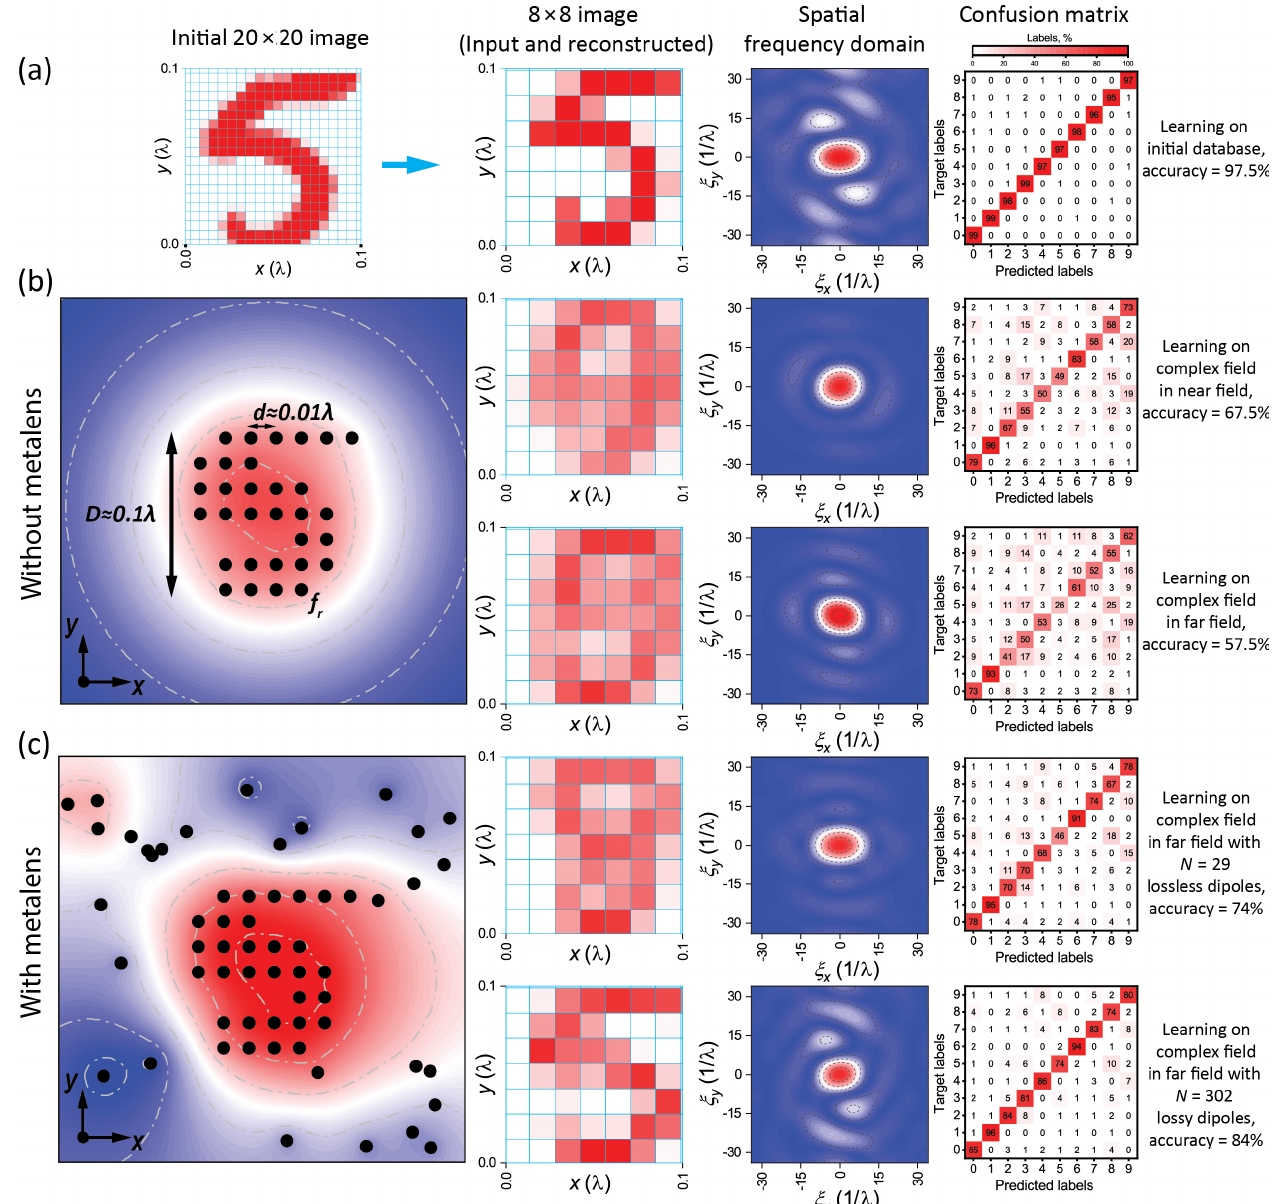
FIG. 2. Demonstration of subwavelength handwritten digits reconstruction and classification based on a semianalytical model of 2D coupled dipoles. (a) The initial ( 20 × 20 )-pixel image of a handwritten digit taken from the MNIST database (left inset) and downsampled to ( 8 × 8 )-pixel image (second column) with corresponding distribution in spatial frequency ξ space (third column). The PCNN classifier trained on the downsampled database reaches an accuracy of 97.5% (the corresponding confusion matrix shown in the right inset). (b) The subwavelength image is modeled by an array of dipoles placed at distances d ≪ λ and with resonance frequency f ≫ f r 0 to inhibit multiple scattering resonance. Reconstructed image (second column) and its corresponding reciprocal space domain (third column), which show the failure of UCNN to recover the higher spatial frequencies. Thus, the accuracy of the PCNN classifier trained on these reconstructed images reaches approximately 67.5% in the near field (top row inset) and 57.5% in the far field R ≫ λ (bottom row inset). (c) Introducing a metamaterial lens that consists of N dipoles with resonance frequency f r ≈ f 0 results in the creation of different multipoles that can radiate, therefore, transferring the near-field information to the far field. The trained UCNN manages to reconstruct better the subdiffraction details of the images, and as a result, PCNN performs with a higher accuracy of approximately 74% for the metalens composed by N ¼ 29 lossless resonators (top row inset). The reconstruction and classification accuracy can be further improved by increasing number of dipoles ( N ¼ 302 ) and adding losses, with the overall accuracy of approximately 84% (bottom row